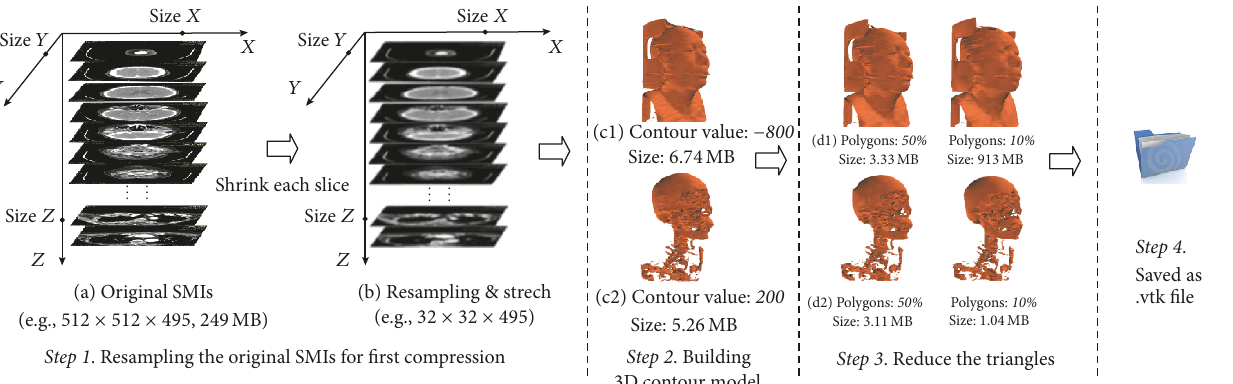
Figure 3: Schematic diagram of the generation and compression of the Slave